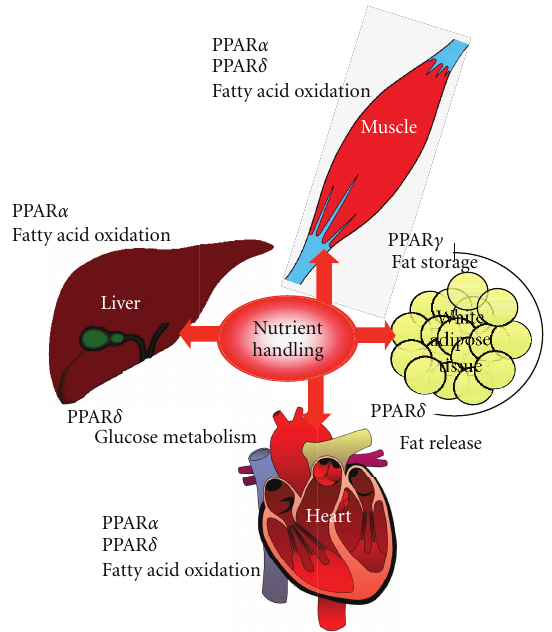
Figure 2: PPAR action in relation to nutrient handling in metabol- ically active